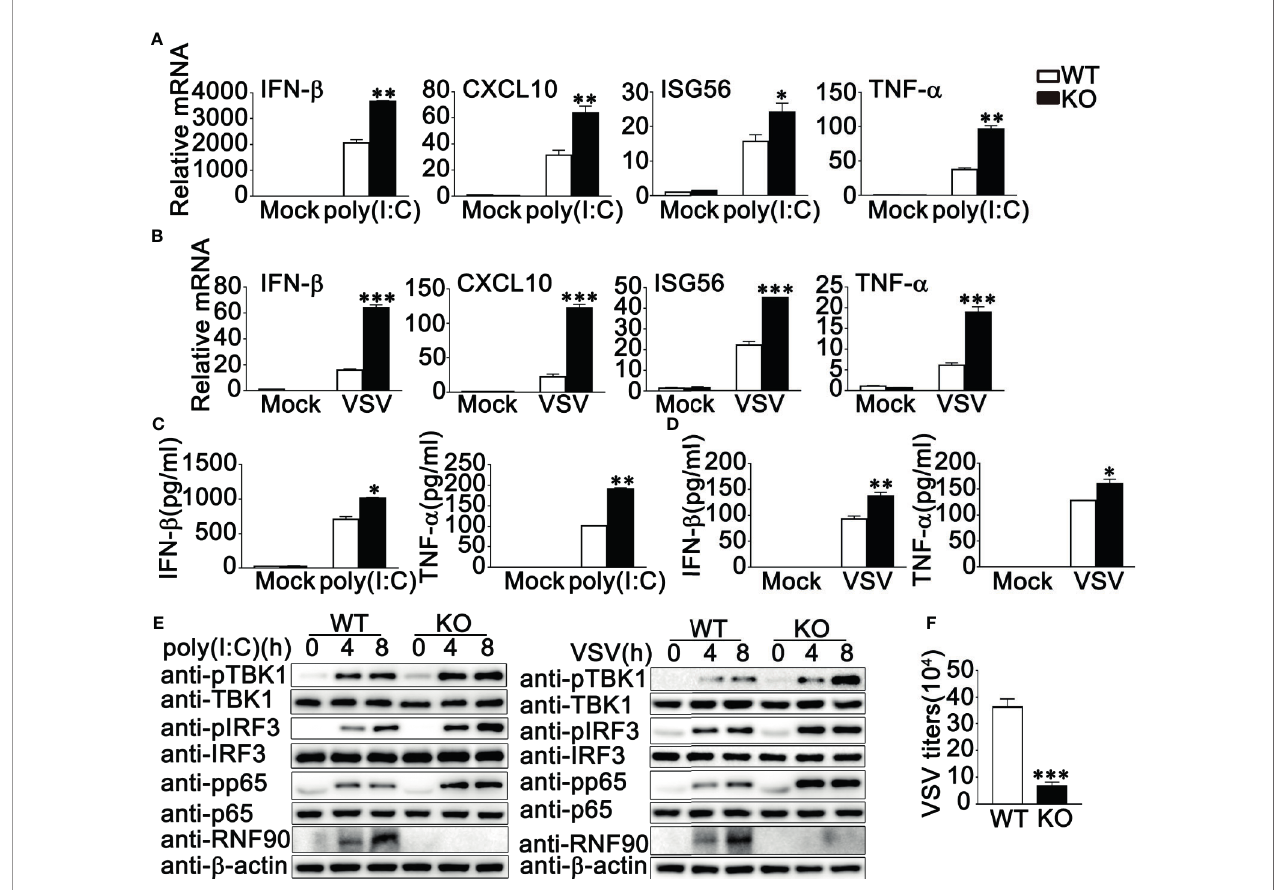
FIGURE 4 | RNF90 de fi ciency promotes RNA virus-triggered innate immune responses in MEFs. (A, B) WT and RNF90-de fi cient (KO) MEFs were treated with poly (I:C) (2.5 m g/ml) (A) or VSV (MOI = 1) (B) for 8 h. The cells were lysed for real-time PCR analysis. (C, D) WT and RNF90-de fi cient (KO) MEFs were stimulated with poly(I:C) (2.5 m g/ml) (C) or VSV (MOI = 1) (D) for 24 h. The supernatants were collected and subjected to ELISA analysis. (E) WT and RNF90-de fi cient (KO) MEFs were transfected with poly (I:C) (2.5 m g/ml) or VSV (MOI = 1) for indicated time points. Then the cells were lysed for immunoblot analysis. (F) WT and RNF90- de fi cient (KO) MEFs were infected with VSV for 24 h. The titers of VSV were determined by standard plaque assays. b -actin served as a loading control in all the immunoblot assays. The data are representative of three independent experiments and are presented as mean ± SEM. * P < 0.05, ** P < 0.01, *** P <